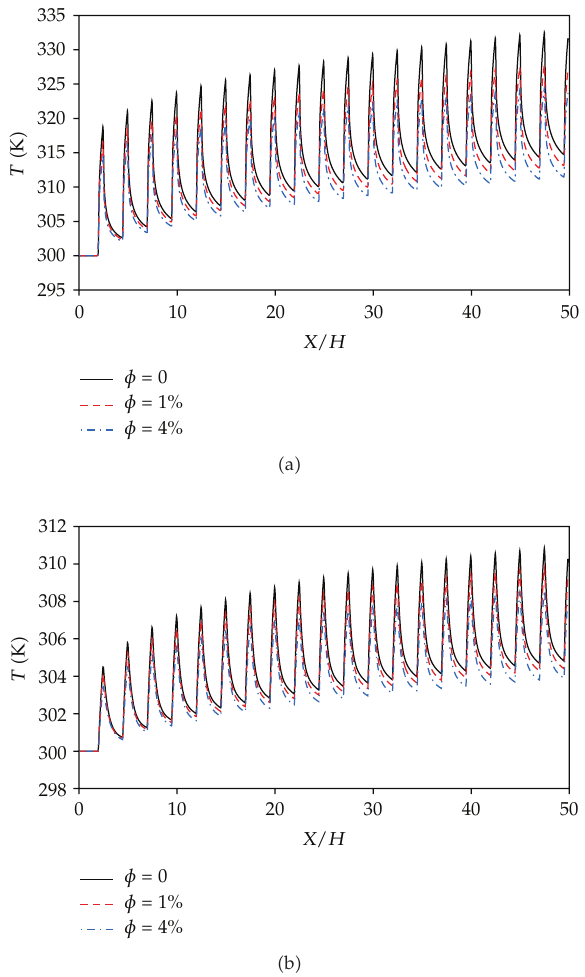
Figure 9: E ff ect of particle loading parameter φ on bottom wall temperature at: (cid:3) a (cid:5) Re (cid:4) 50, (cid:3) b (cid:5) Re (cid:4)